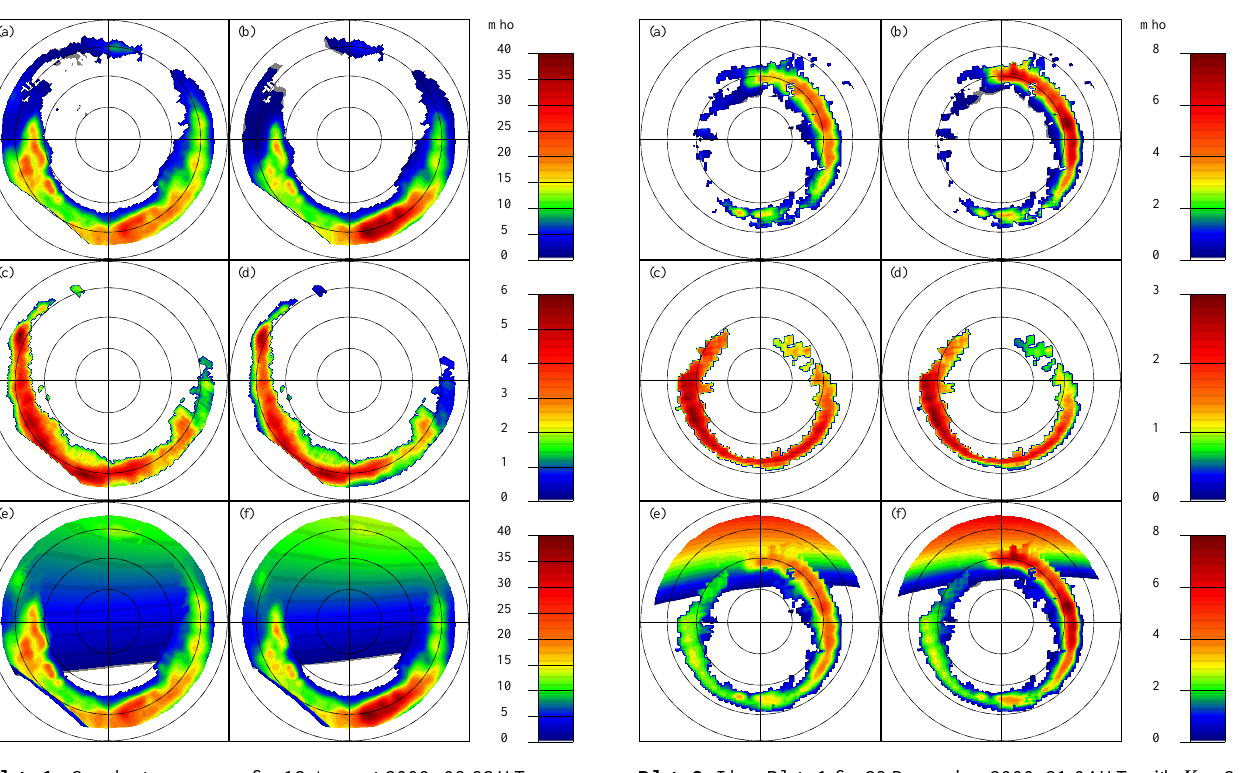
Plate 1. Conductance maps for 12 August 2000, 08:32UT corre- sponding to a summer substorm ( K p =8). Panels (a) and (b) show, respectively, Pedersen and Hall conductances induced by auroral electron precipitation. Panels (c) and (d) show, respectively, Ped- ersen and Hall conductances induced by protons and panel (e) and (f) show conductance maps induced by both auroral particles and EUV solar radiation. Circles show 50 ◦ , 60 ◦ , 70 ◦ and 80 ◦ MLAT. The local midnight is located downward.